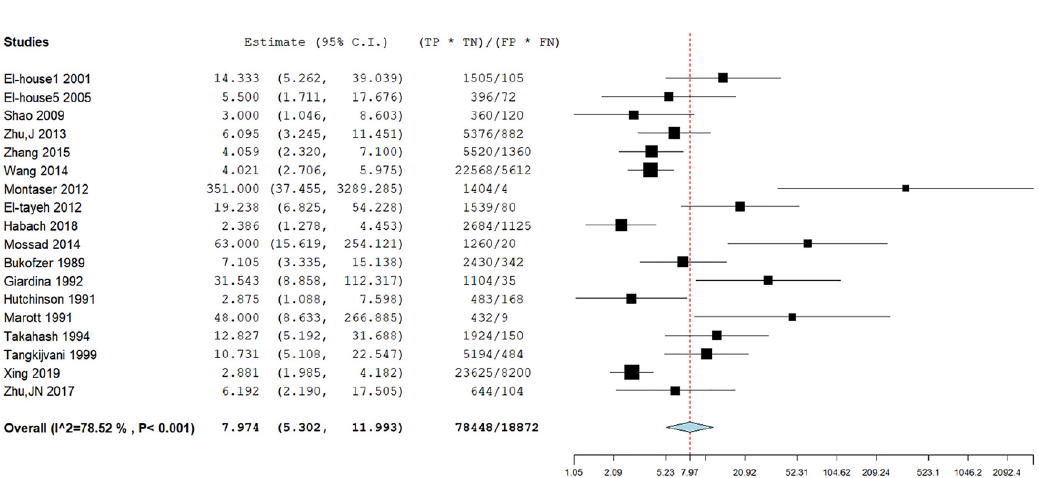
Figure 2: Summary of risk of bias and applicability concerns.